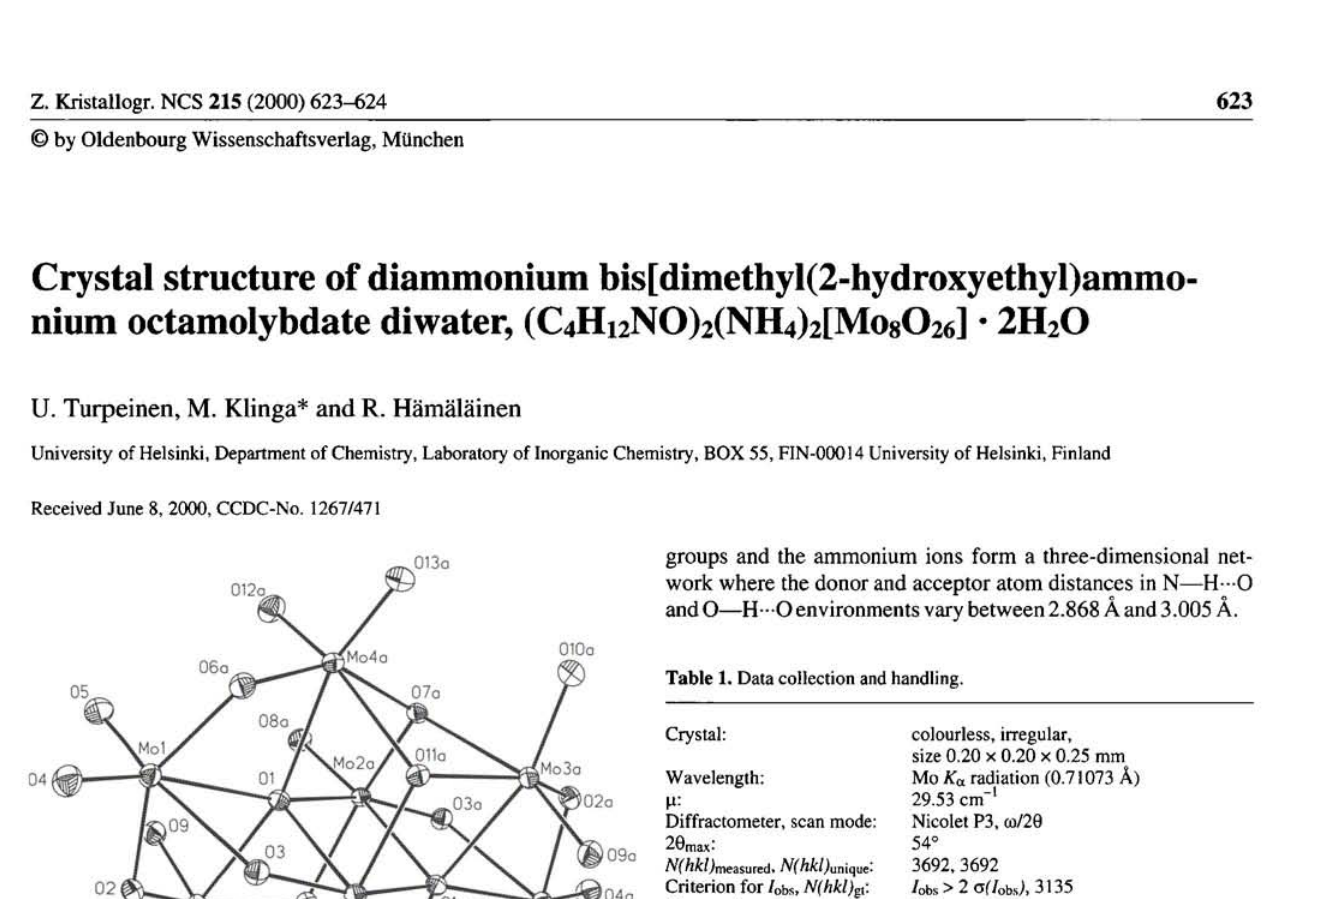
Table 2. Atomic coordinates and displacement parameters (in Â 2